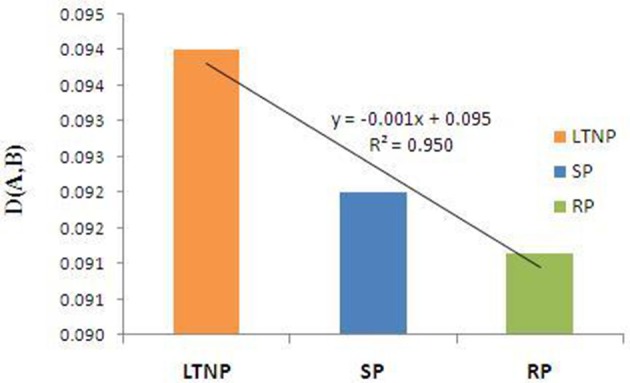
Similarity index [D(A,B)] of env genes (LTNP, SP, and RP) with respect to human host. Orange bar refers to similarity index value [D(A,B)] of Long term non-progressor (LTNP) sequences. Blue bar represents the similarity index value [D(A,B)] of the Slow progressor (SP) sets. Green bar depicts the similarity index value [D(A,B)] of the Rapid progressor (RP) sequences.